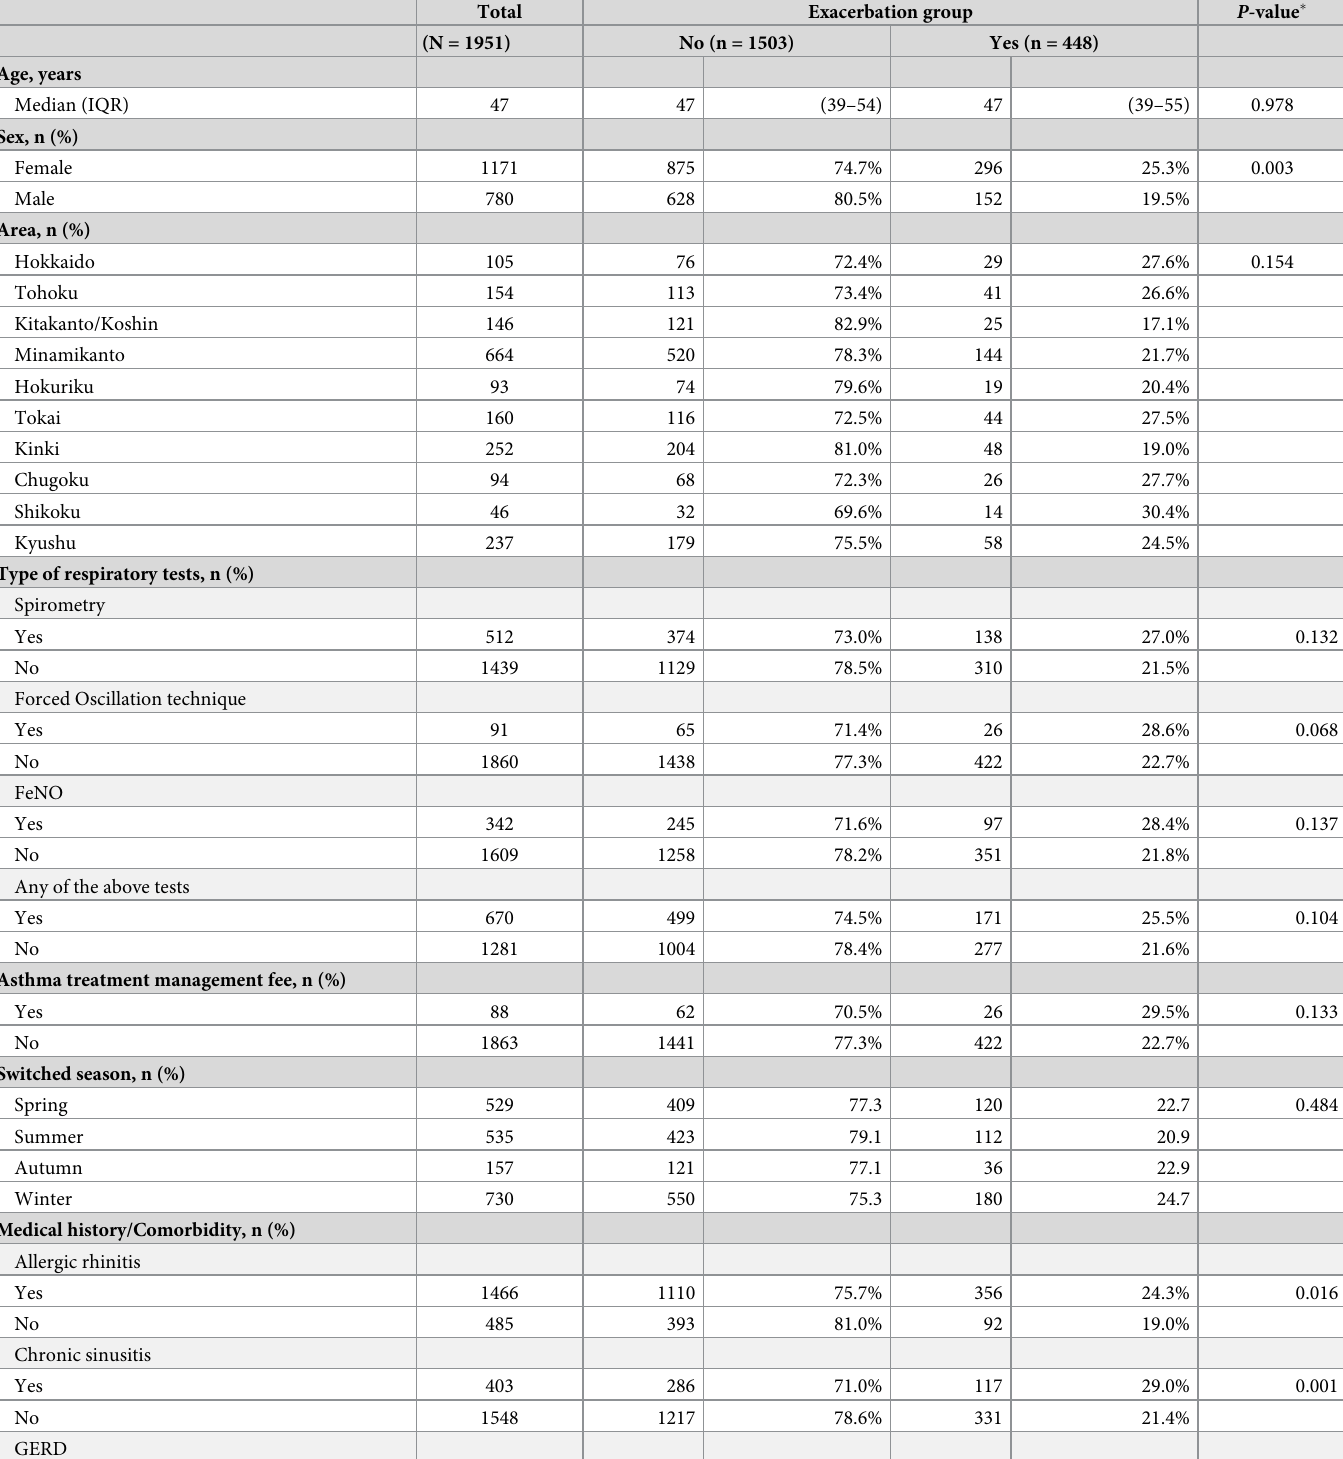
Table 1. Baseline characteristics of patients. � P -values were derived using the chi-square test for categorical variables and the Wilcoxon rank sum test for continuous